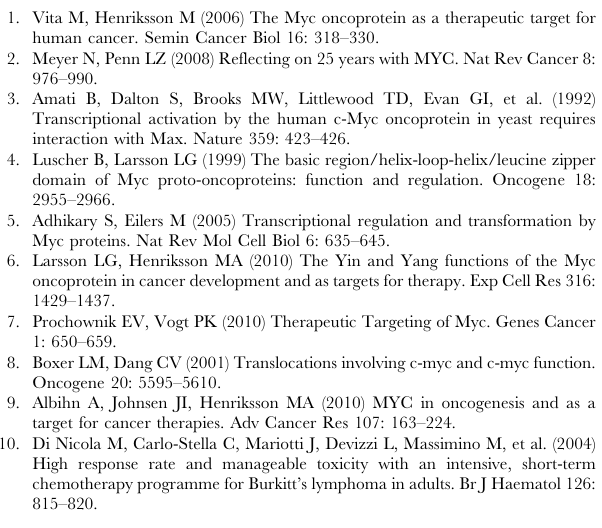
Figure S3 Cytotoxic drugs do not mimic the effect of doxycycline on the Tet-OFF promoter. CHO-AA8 Tet- OFF-Luc cells were treated for 48 h with 1 m M of the indicated cytotoxic drugs or with 1 m g/ml doxycycline. Luciferase activity was assayed with the Dual-Luciferase Reporter Assay and the luciferase signal was normalized to the protein concentration in each extract analyzed. Data represent triplicates in each experiment and error bars indicate standard deviation. Table S1 Characteristics of the reference substances used in the study. List of the 80 compounds in the chemical library and their cellular targets. The effect on viability in cells overexpressing MYCN or c-MYC relative to non-overexpressing cells is shown for each